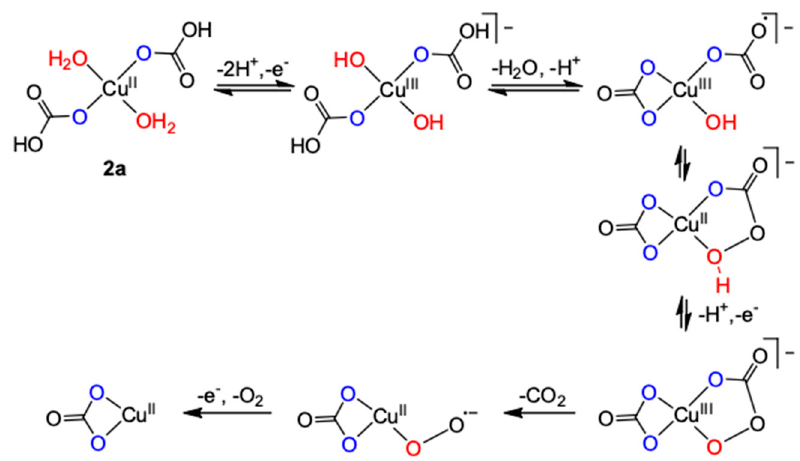
Figure 3. Initial oxidation steps of copper-carbonate suggested by Winikoff and Cramer starting from the conformer 2a (only selected ones are shown here), and the final steps relevant to the catalytic cycle at pH = 8.2 in 1 M carbonate [22]. Table 1. 1 Kinetic, electrochemical data and reaction conditions of single-site water oxidation catalysts with inorganic ligands and